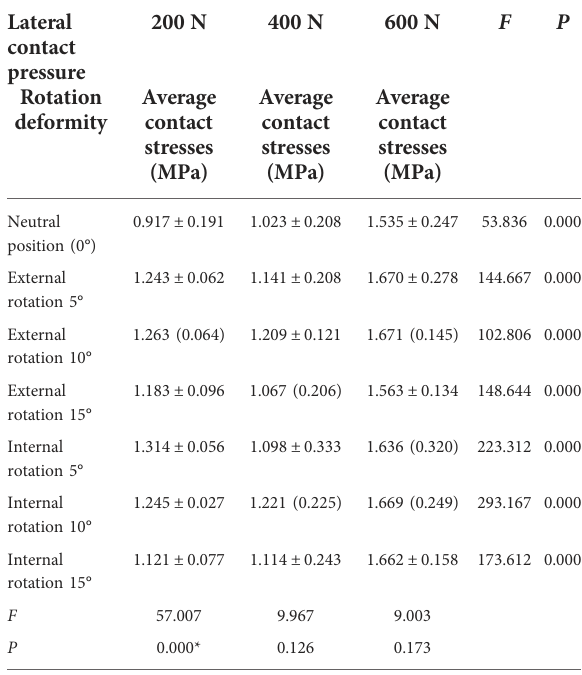
TABLE 2 Value of lateral femoral – tibial contact stresses at various rotatory angles